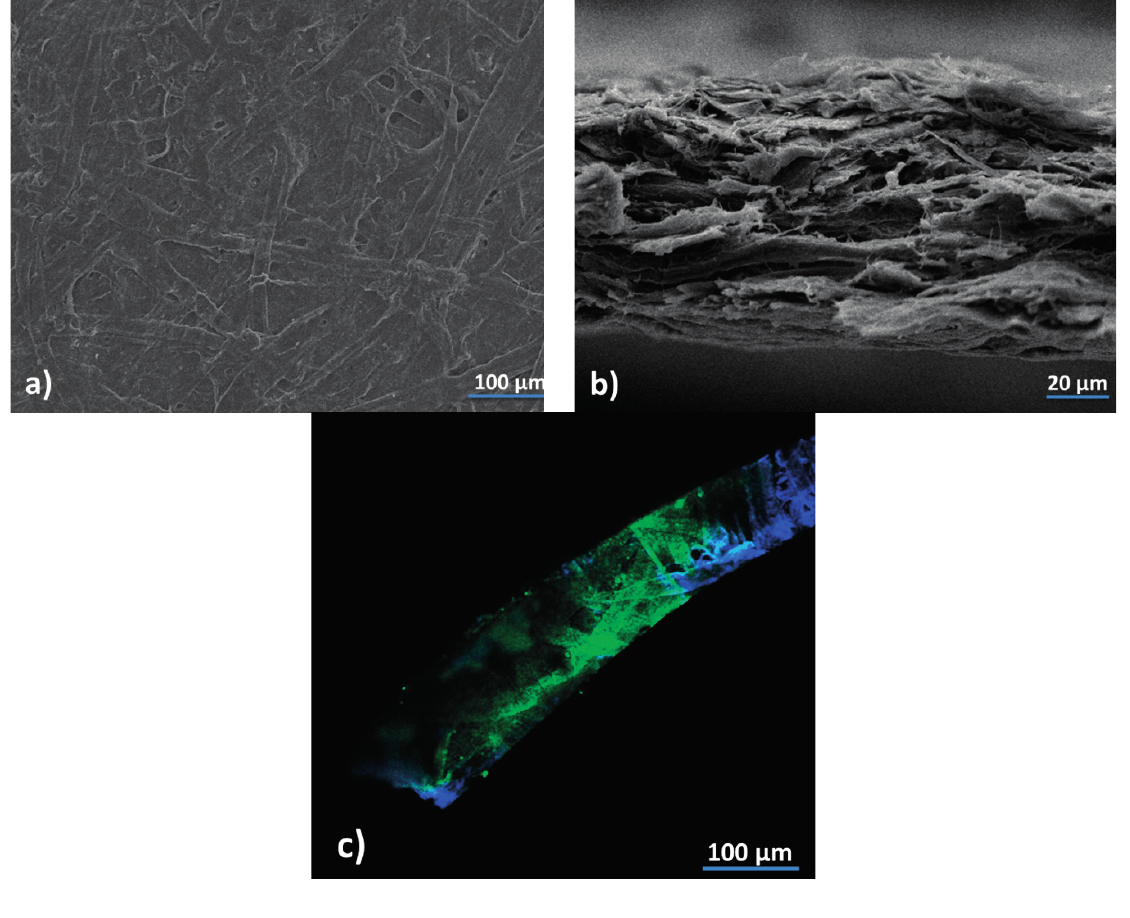
Figure 2. SEM (Scanning Electron Microscopy) and confocal micrographies of a film of PLA-SC 1.5% 10 pph: ( a ) Front view, 200×; ( b ) Transversal cut 1000×; and ( c ) Confocal micrography,